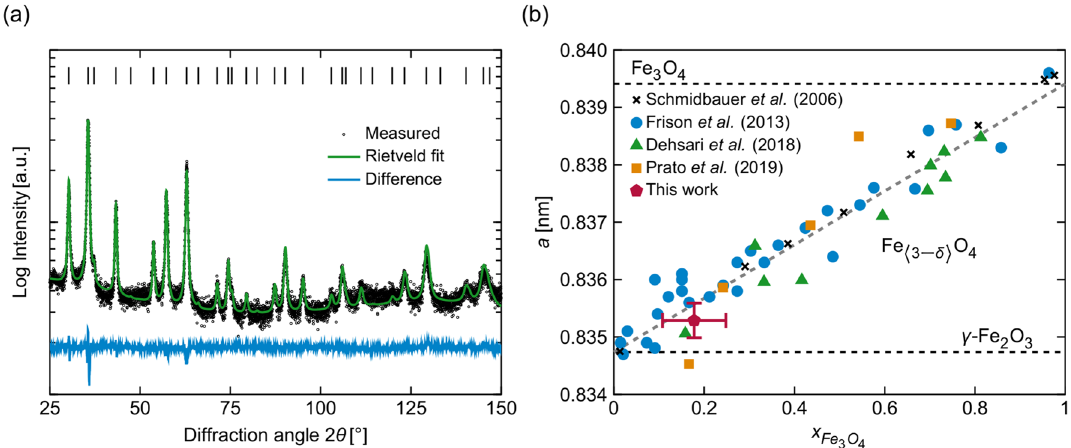
Figure 1. ( a ) XRD pattern of the IONFs under study. Rietveld refinement was carried out using space group 3 m . ( b ) Dependence of the cubic lattice parameter of IONPs on their stoichiometry. The horizontal dashed Fd ¯ lines mark the lattice parameters of Fe 3 O 4 and γ -Fe 2 O 3 . The Vegard dependence (ascending gray dashed line) was calculated for large crystallites ( D in Eq. (1)). The black crosses 49 , blue circles 29 , green triangles 13 → ∞ and orange squares 14 represent values taken from literature; the red pentagon with error bars marks the lattice parameter from the present